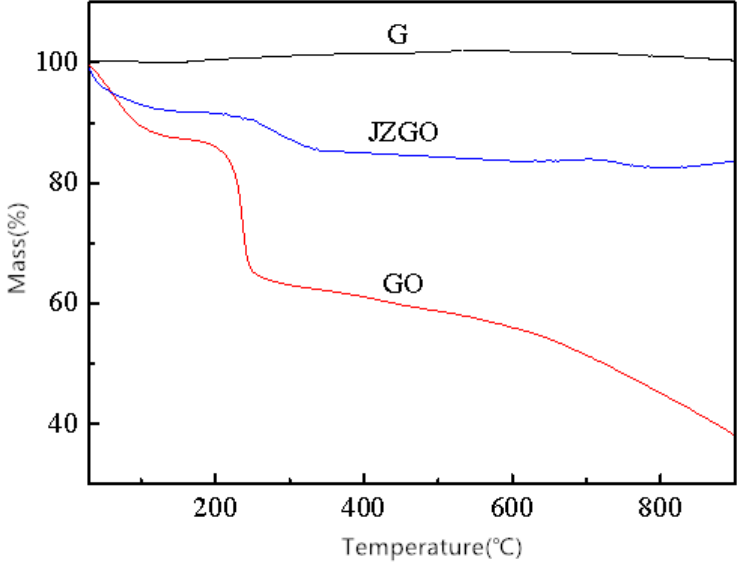
Figure 9. TG curves of graphite (G), graphene oxide (GO) and activated graphene (JZGO).